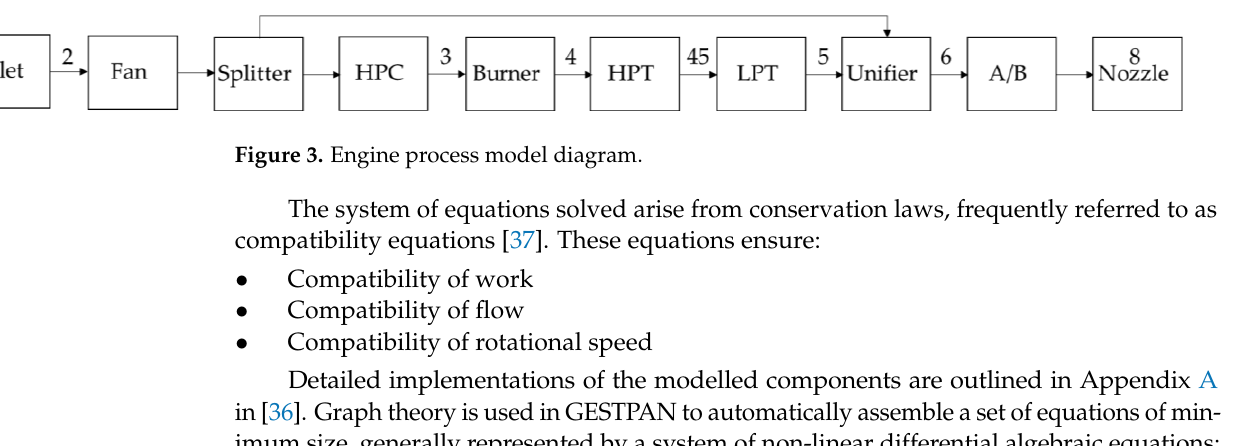
Figure 3. Engine process model diagram.